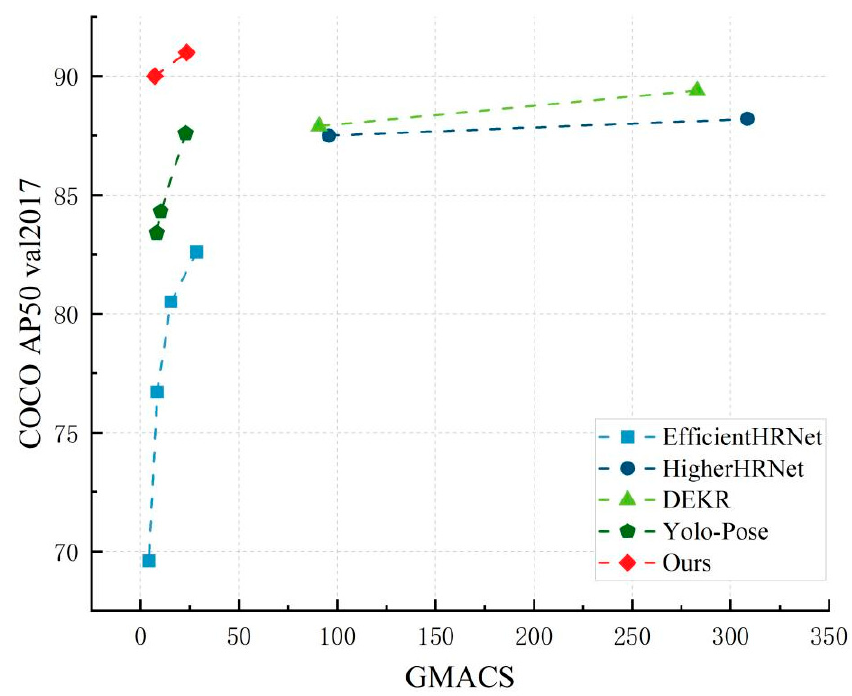
Figure 6. AP50 vs. GMACS on COCO 2017 Validation Dataset.